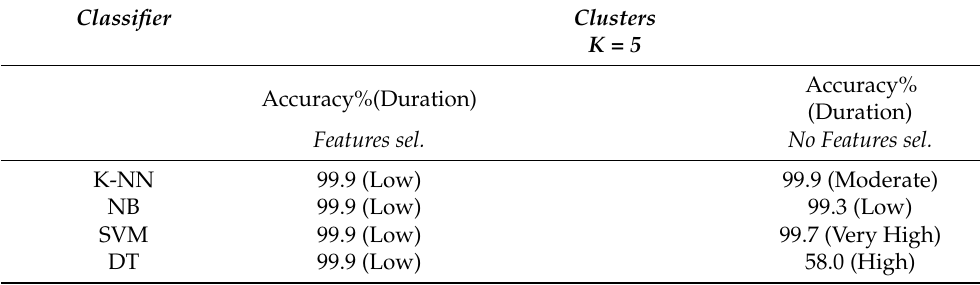
Table 2. Comparison of the accuracies of different methods evaluated using testing